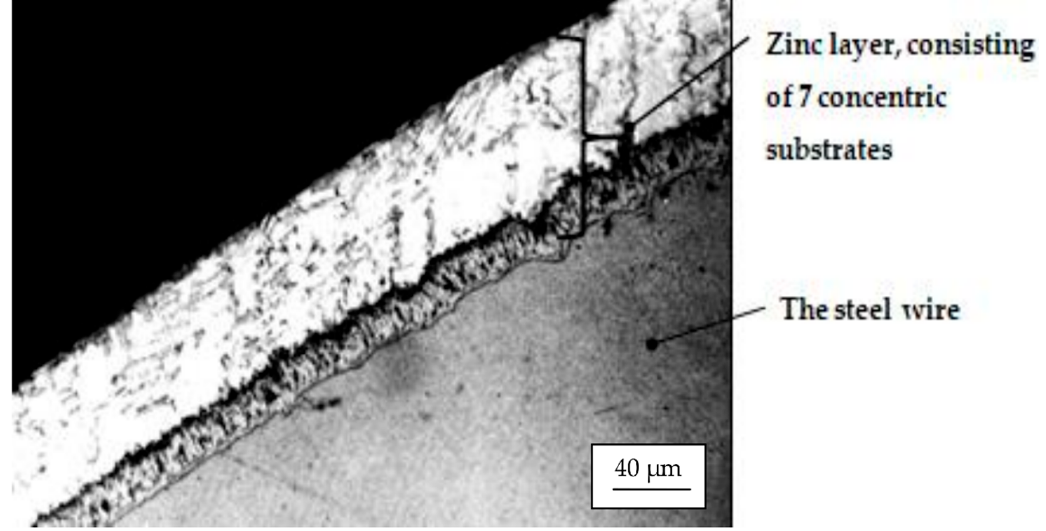
Figure 5. The structure of the Zn layer, “Hot Dip”, deposited on the steel wire surface.